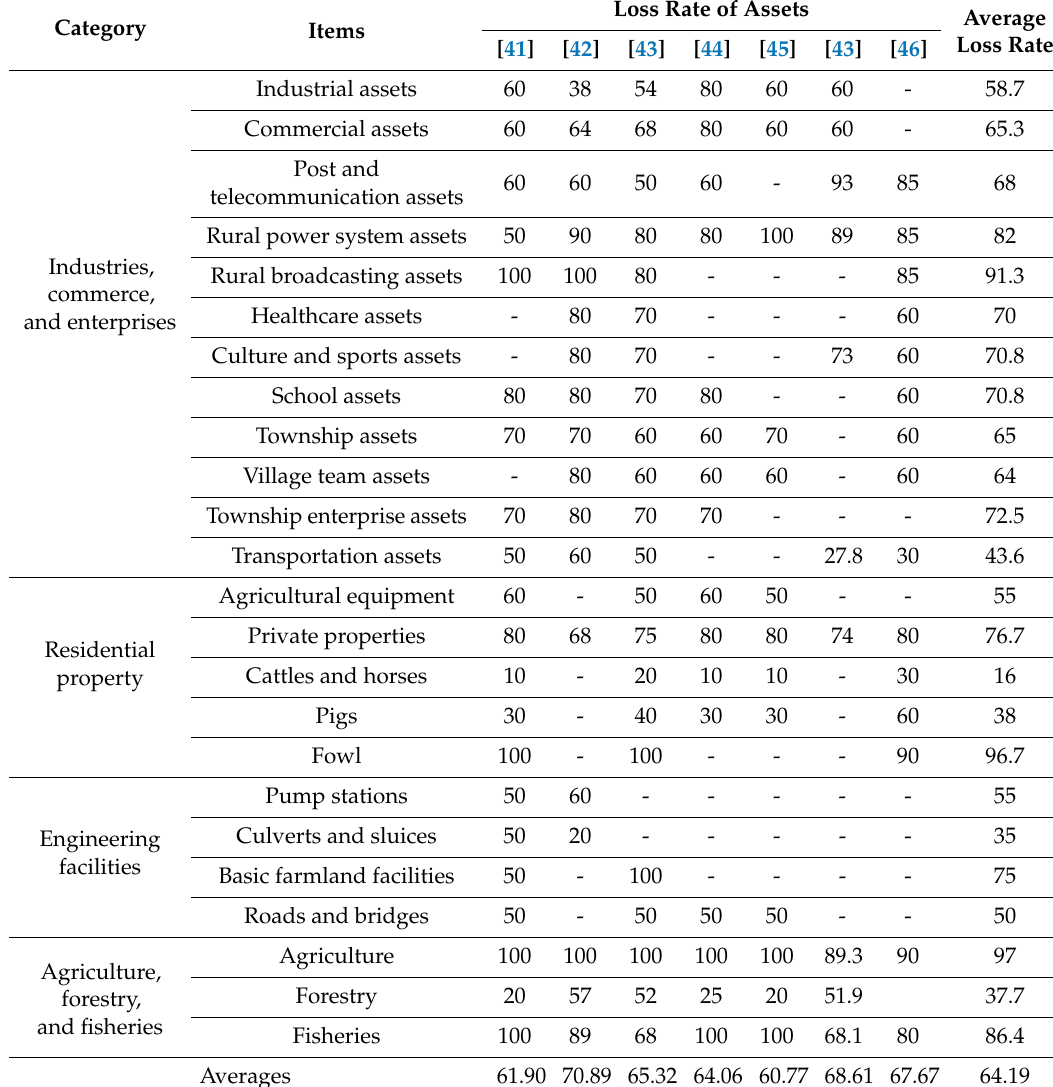
Table 4. Flood loss rate in flood storage and detention areas of the Yangtze River